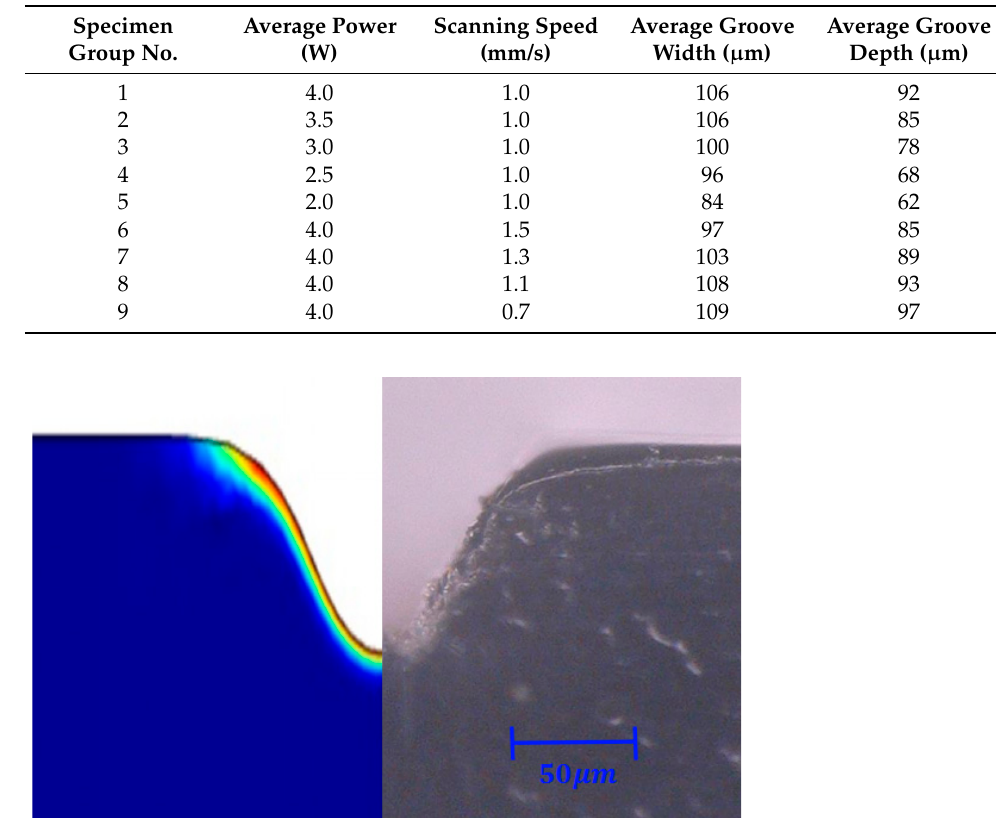
Table 2. Statistical table of groove width and depth of PMMA specimen processed by femtosecond laser direct writing.